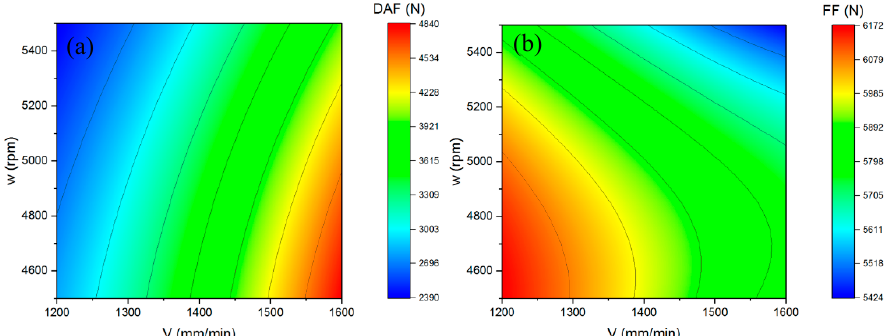
Figure 10. Contour plots of: ( a ) The downward axial force during the RAFSW process; ( b ) Failure force at a tensile shear test versus welding traverse speed ( V ) and welding rotational speed ( w ) while other geometry and process parameters are the same as parameters of sample No. 21. The contour plots were extracted from developed ANN models in this paper.